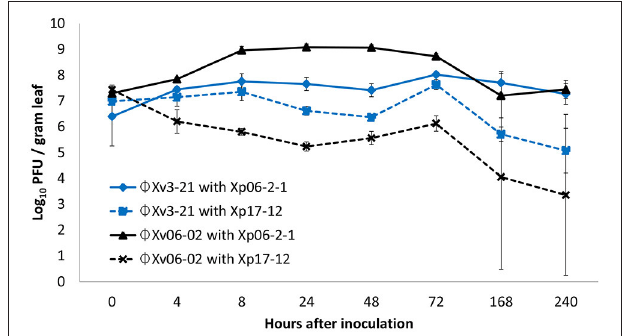
FIGURE 1 | Populations of phages 8 Xv3-21 and 8 Xp06-02 in the tomato phyllosphere in the presence of Xanthomonas perforans strains Xp06-21 or